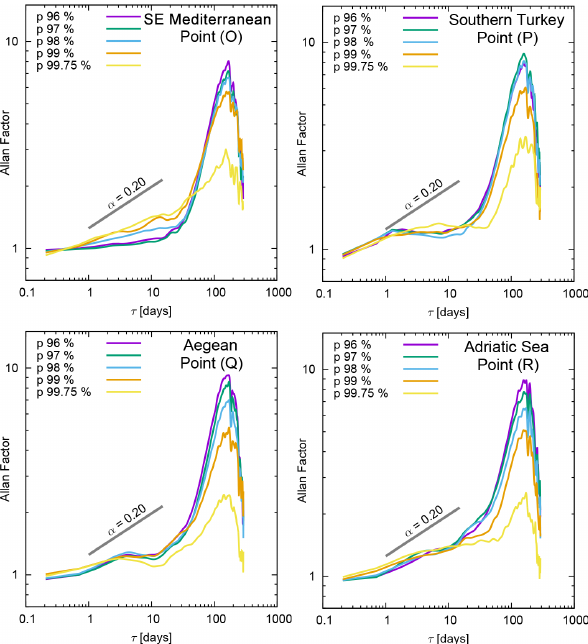
Figure 11. Allan factor (AF) as a function of counting window τ and of the wave height threshold (different percentiles as in the leg- end) for different locations in the Mediterranean Sea (cf. Fig.